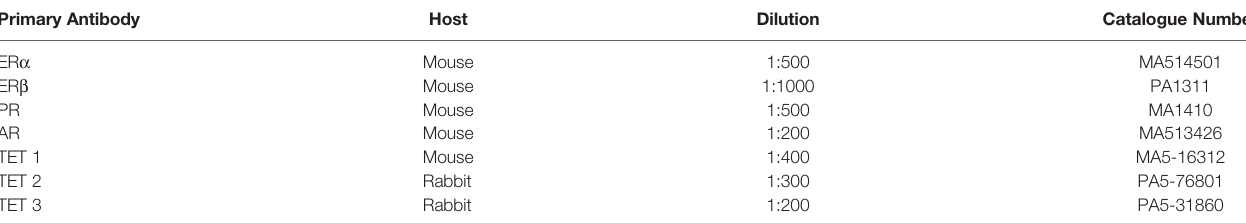
TABLE 2 | Details of primary antibodies used and their